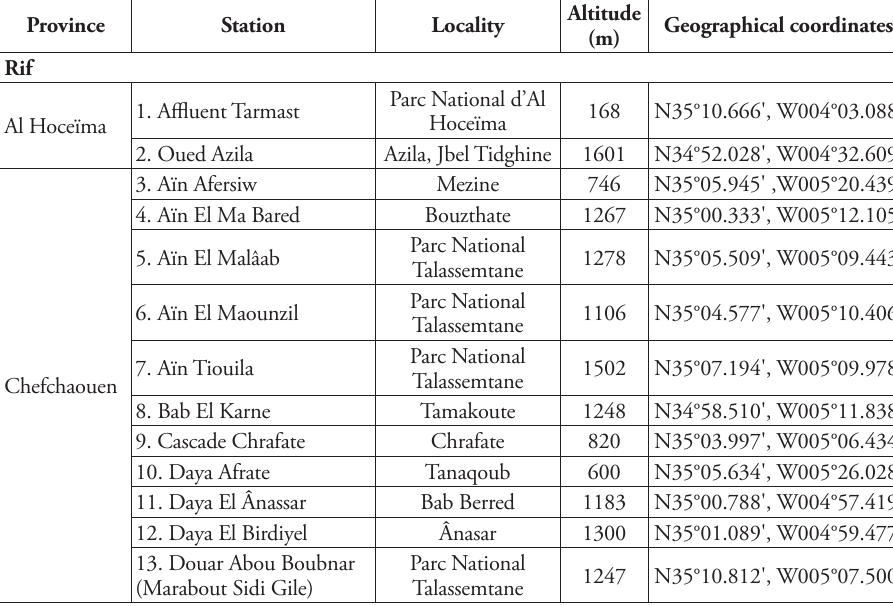
Table 2. Sampling sites (in alphabetical order) harboring the species collected in Morocco with localities, geographical coordinates, and